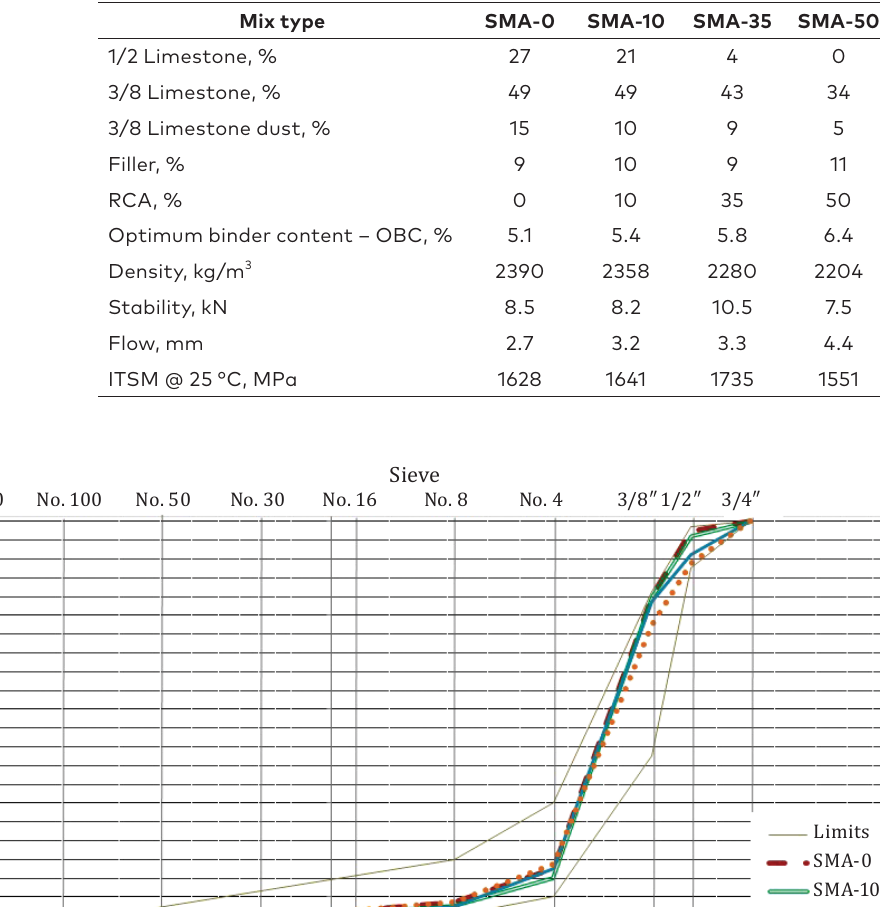
Table 2. Summary of blended mix designs and volumetric